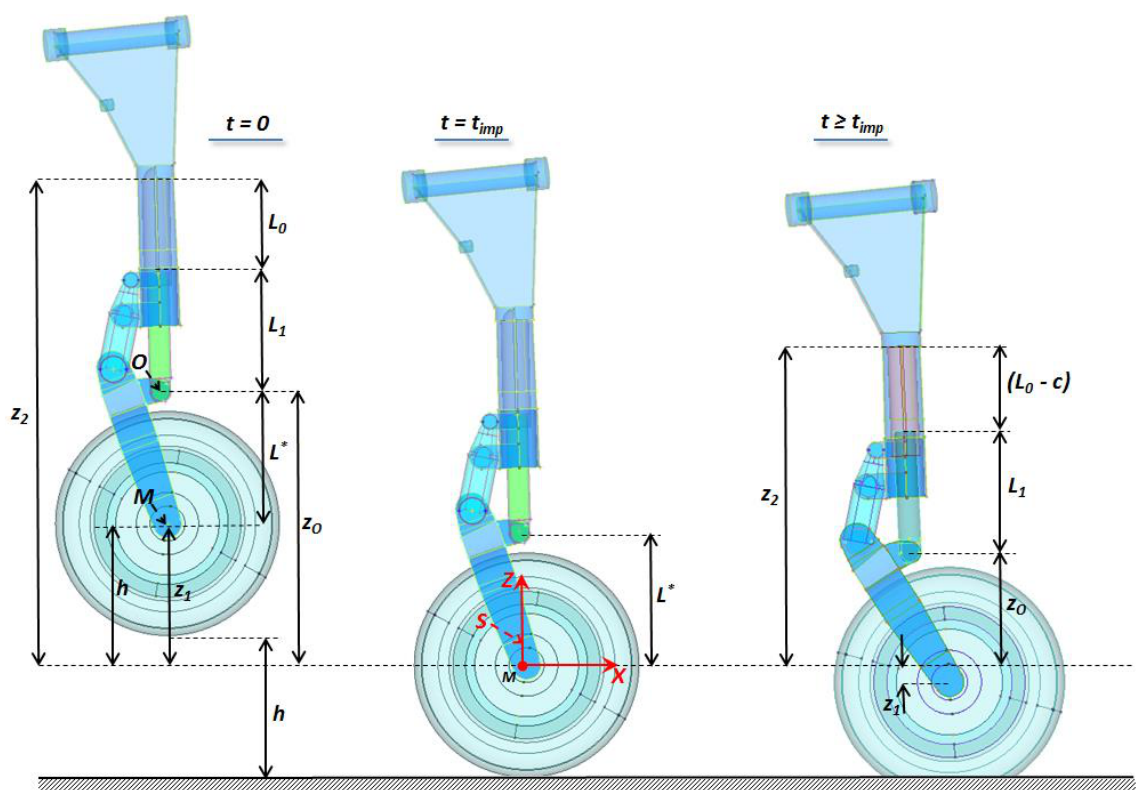
Figure 2. Phases of landing gear drop and main parameters involved in impact dynamics. x 1 , z 1 : x - and z -coordinates of point M located at the center of the wheel hub; z 2 : z -coordinate of the cylinder head; and φ : wheel rotation angle.